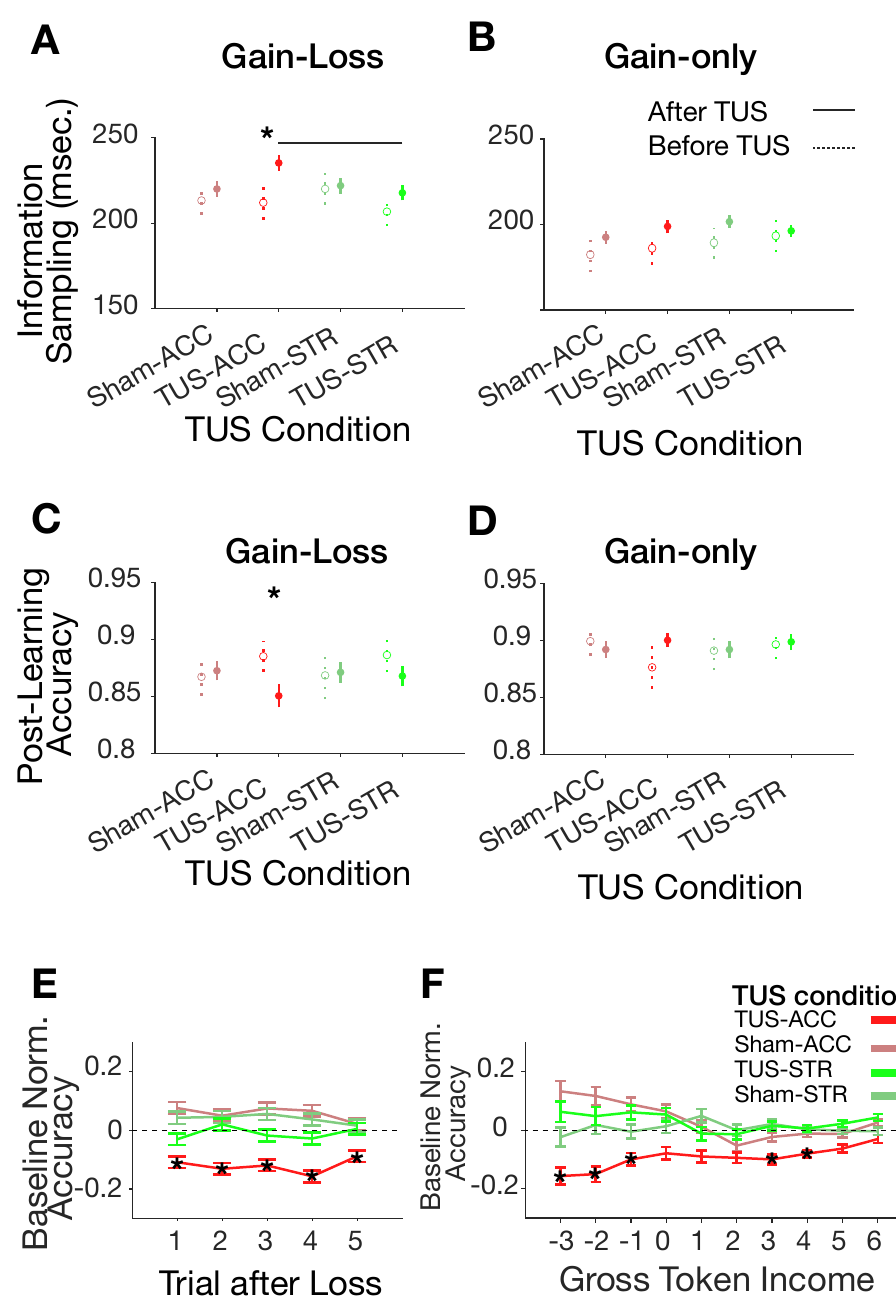
Fig 3. TUS effect on fixational information sampling and behavioral adjustment after gains and losses. ( A , B )